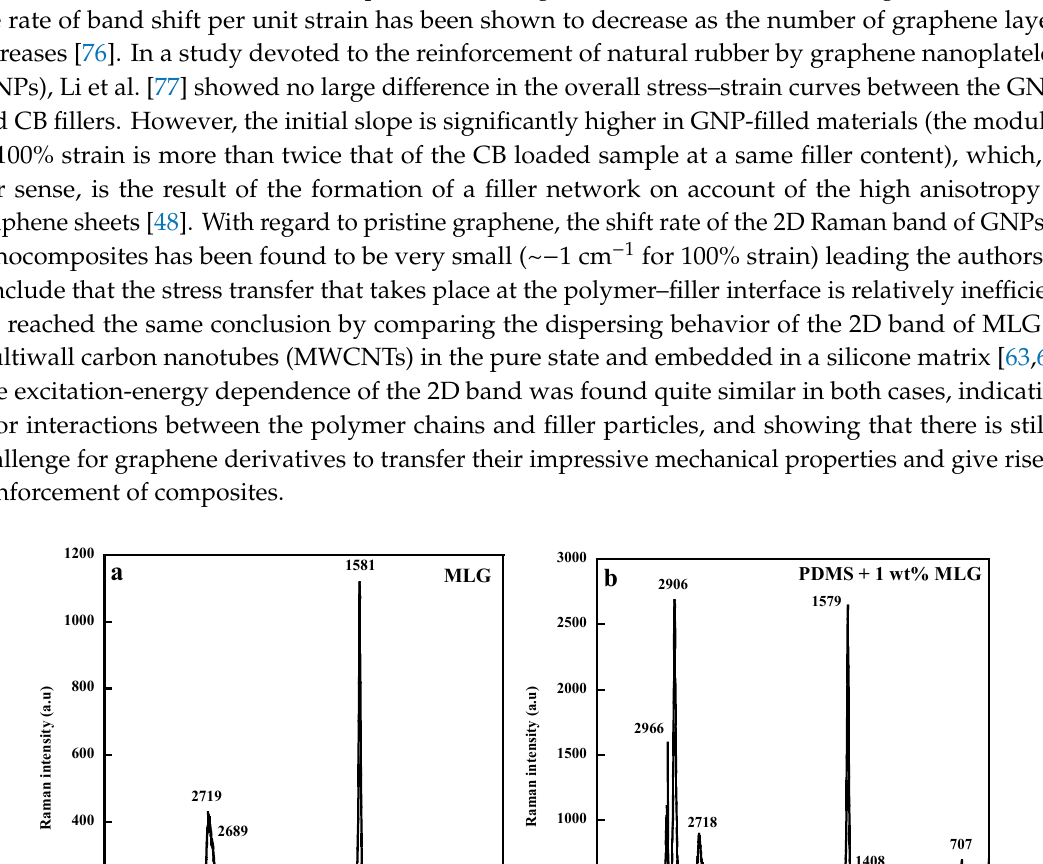
Polymers 2019 , 11 , x FOR PEER REVIEW 10 of 13